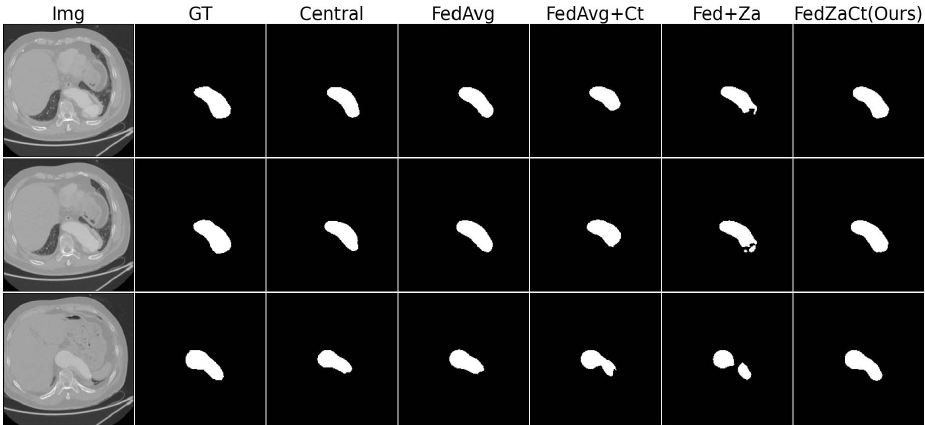
Figure 2. The comparison of qualitative examples on the private aortic dataset.